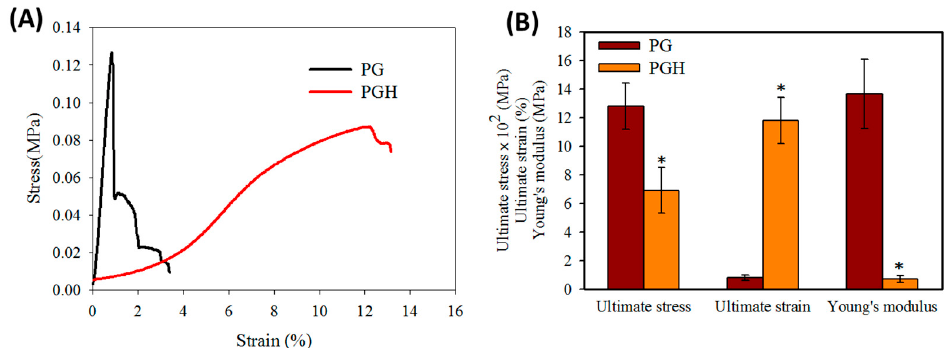
Figure 3. The tensile mechanical properties of PG and PGH fibrous membrane scaffold (FMS). ( A ) The typical stress–strain curves. ( B ) The ultimate stress, ultimate strain and Young’s modulus ( n = 4). * p < 0.05 compared with PG.